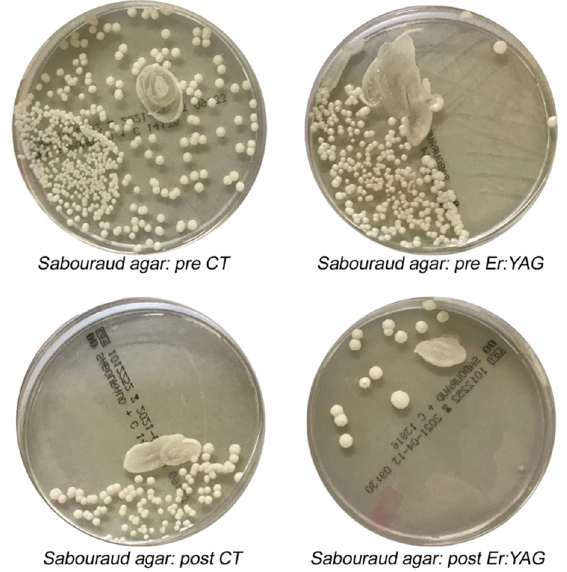
Figure 5. Difference in Candida albicans ( C. albicans ) colonies growth after Er:YAG treatments ( right ) vs. CT ( left ). Pre CT: pre-treatment with conventional therapy; post CT: post-treatment with conventional therapy; pre Er:YAG: pre-treatment with laser therapy; post Er:YAG: post-treatment with laser therapy. Table 2. This table report the percentages of colony-forming units (CFUs) reduction (%) and CFUs performed in triplicate (mean ± SD) for each micro-organisms macro-group considered for both the intervention group B (Er:YAG) and vs. the control group A (CT) samples. A comparison of the CFUs percentages of reduction and mean CFUs (SD) for post- and pre-treatment between group B (Er:YAG) and group A (CT) was performed for each of the four selected macro-groups of micro-organisms. * p < 0.05. The mean CFU was only performed in the culture media in which there was the growth of the genus under investigation.